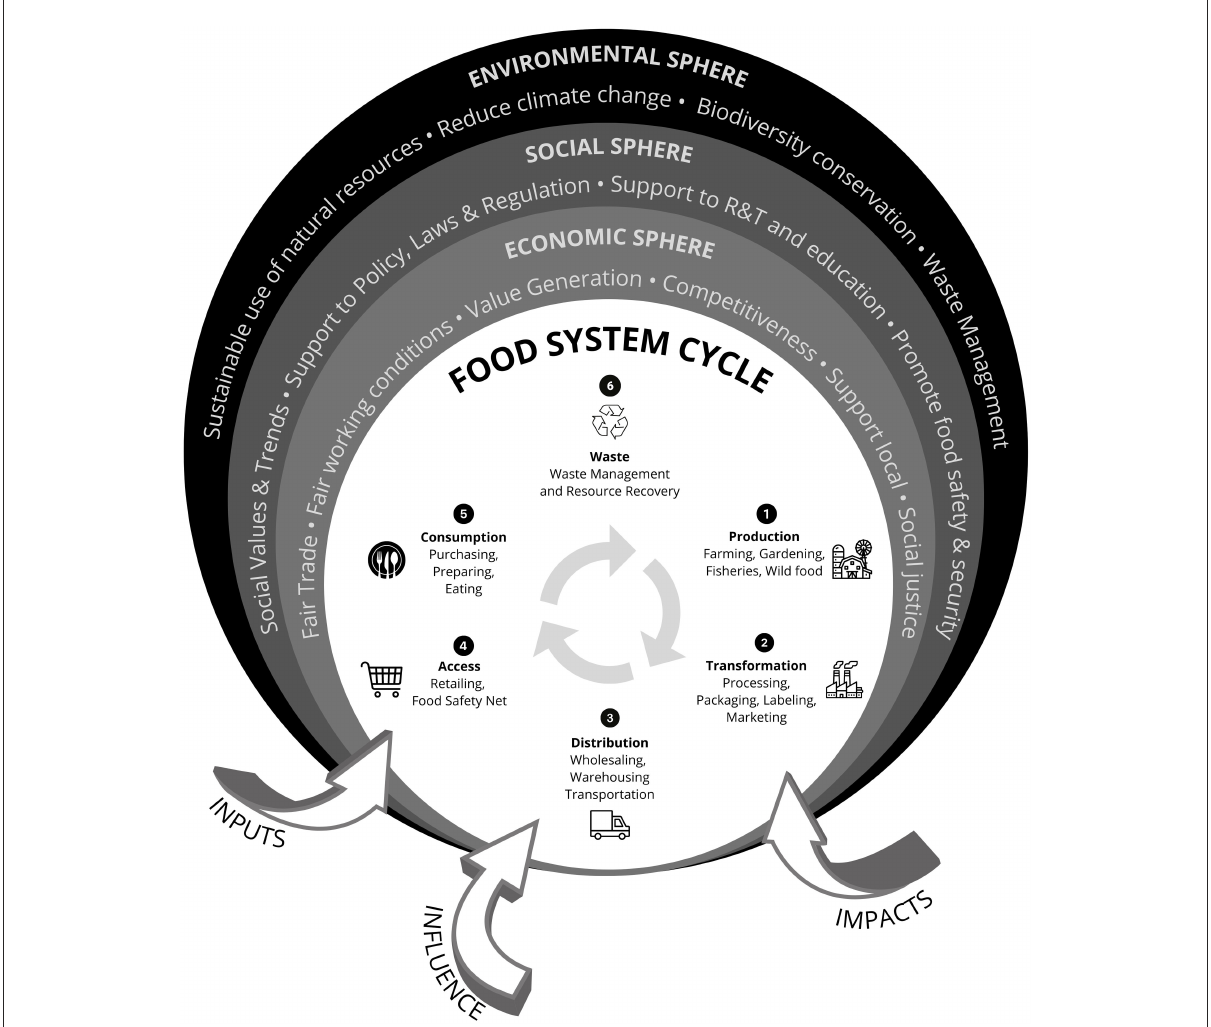
FIGURE4 Representative scheme of a sustainable food system. R&T, Research & Technology; Inputs, Human Resources (e.g. laborers, managers, professionals) and Natural Resources; Impacts, Outcomes; Influence, Social and Economic Sphere (Harmon and Gerald, 2007; von Koerber et al., 2017; Nguyen, 2018; Bhunnoo and Poppy,